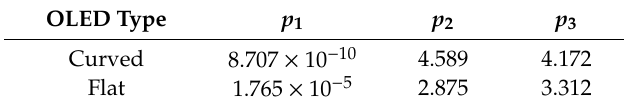
Table 2. Numerical modeling parameters for τ RMS in the case of using flat and curved OLEDs in o ffi ce. OLED